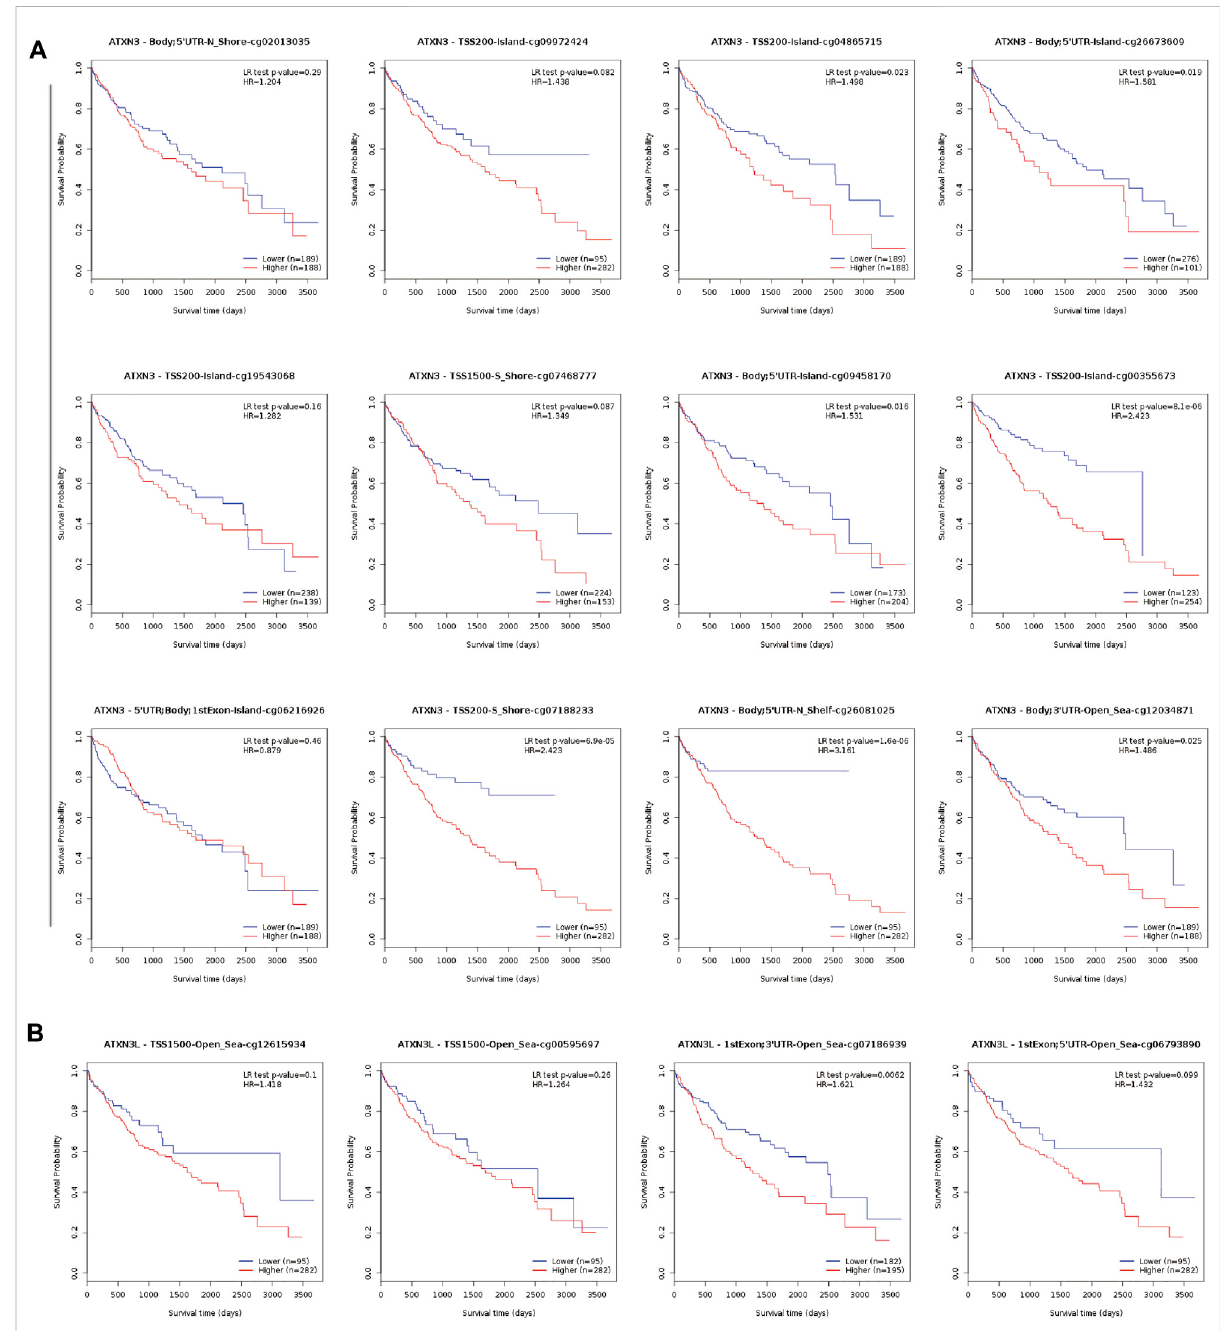
FIGURE 8 Kaplan-MeiersurvivalcurvescomparingthehighorlowexpressionofMJDsmethylationsitesinHCC(MethSurv).Kaplan-Meiersurvivalanalysis of (A) ATXN3 and (B) ATXN3L methylation sites were